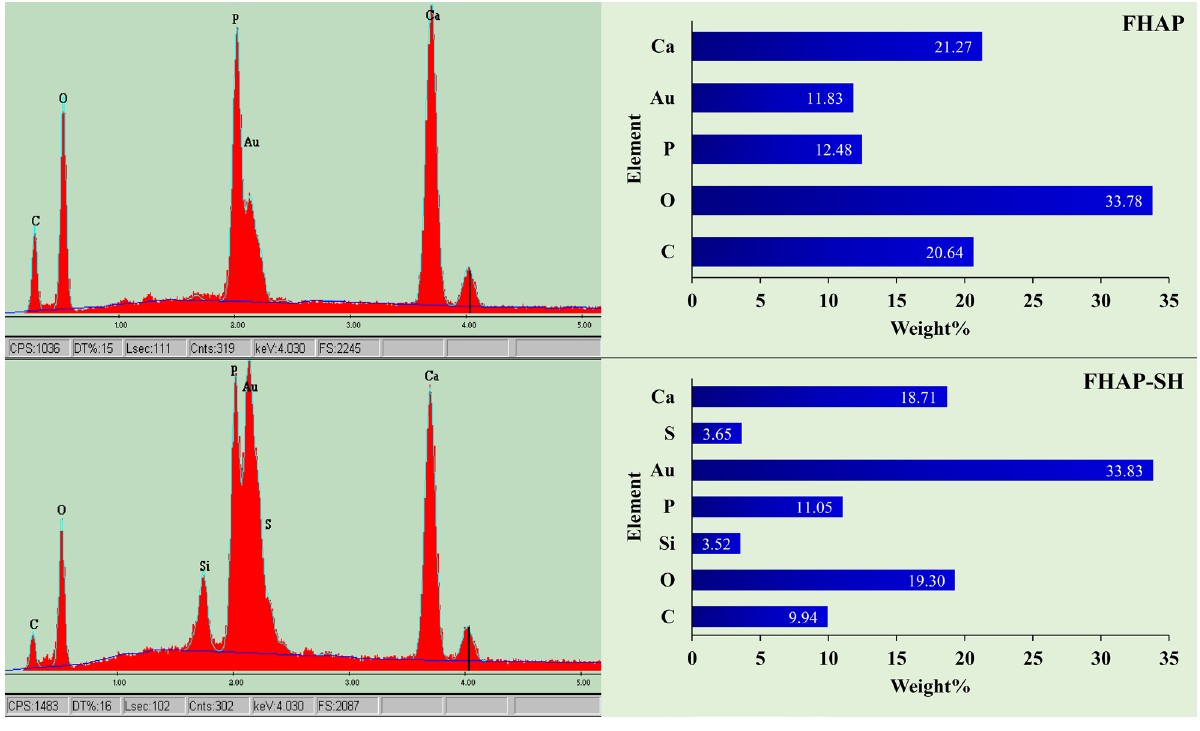
Figure 3. EDX spectra of the FHAP and